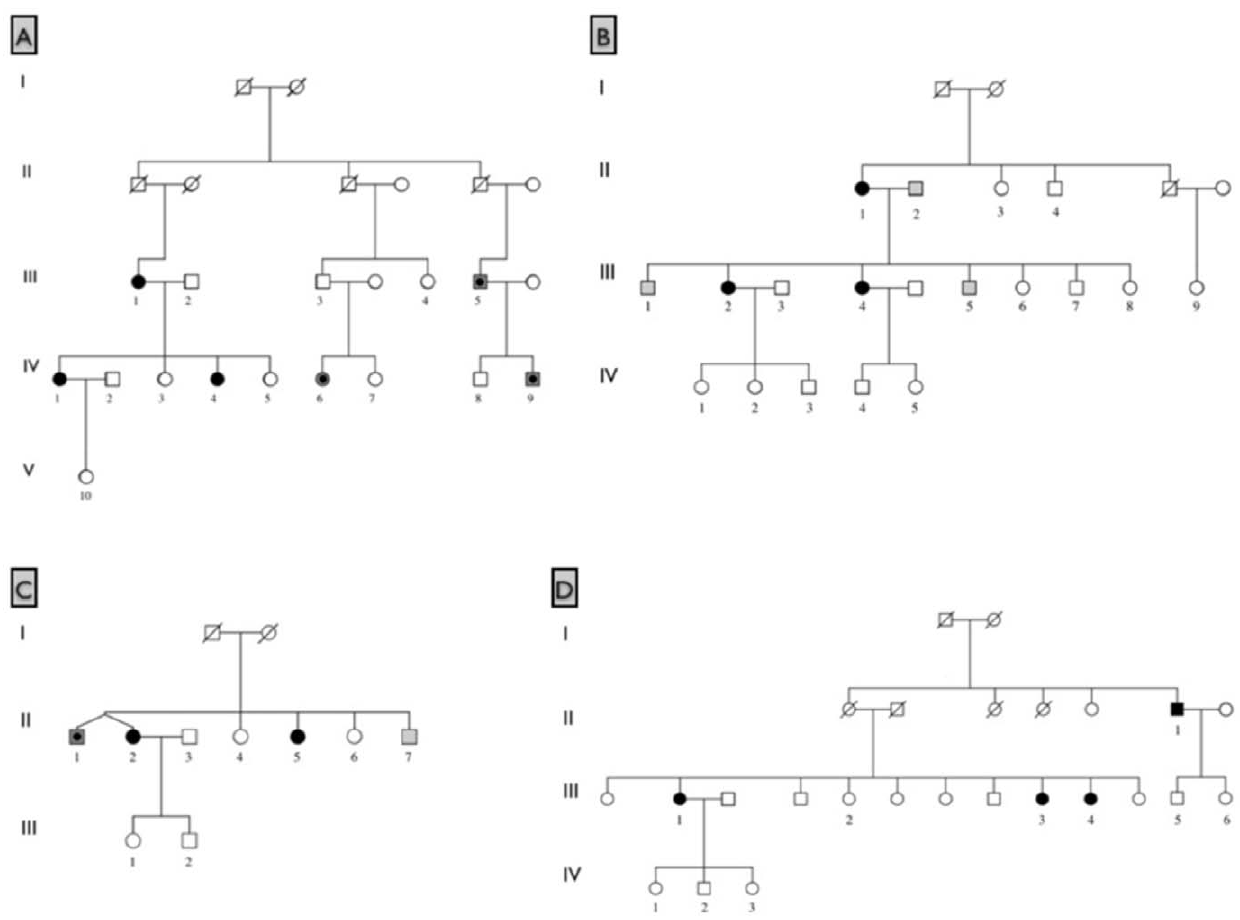
Figure 1. Four families with multiple relatives affected with MacTel. Black shaded symbols represent affected; dark gray shading represents possibly affected; light gray shading represents probably not affected; unshaded symbols represent unaffected or unexamined relatives. Numbered individuals were enrolled and examined.